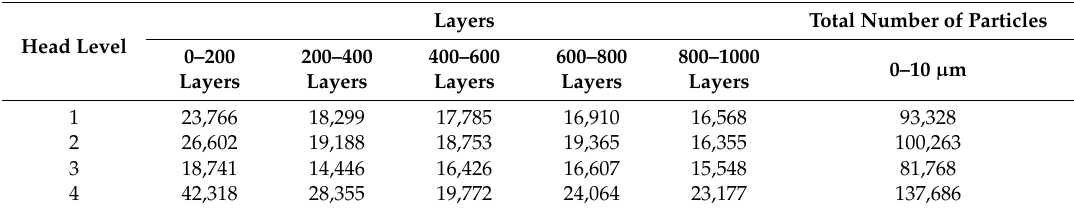
Table 11. Variation in the number of fine particles percolated with the 50% fine particle content (0–10 µ m).